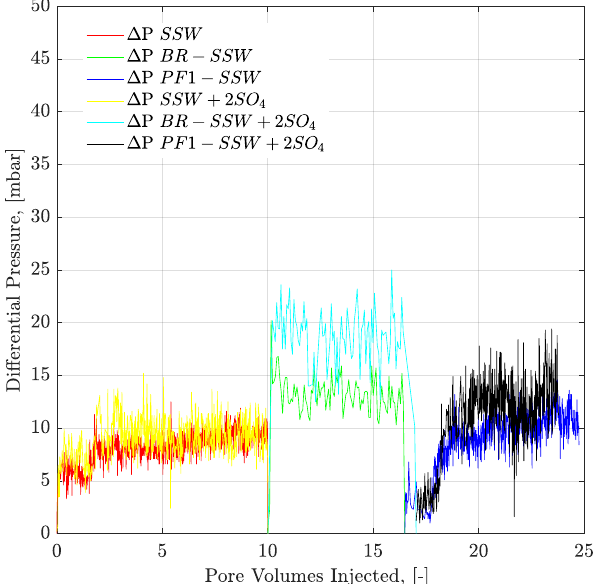
Figure 15. Pressure drop versus PV injected for complex-wet micromodel. Polymer (half to the oil viscosity) flooding in tertiary mode after the brine flood in secondary mode. ∆ P SSW represents the pressure drop for synthetic seawater. ∆ P BR-SSW represents the pressure drop for synthetic seawater bump rate. ∆ P PF1-SSW represents the pressure drop from polymer injection prepared in synthetic seawater having viscosity half to the oil. Similarly ∆ P SSW + 2SO 4 denotes pressure drop for synthetic seawater with doubled amount of sulfate.